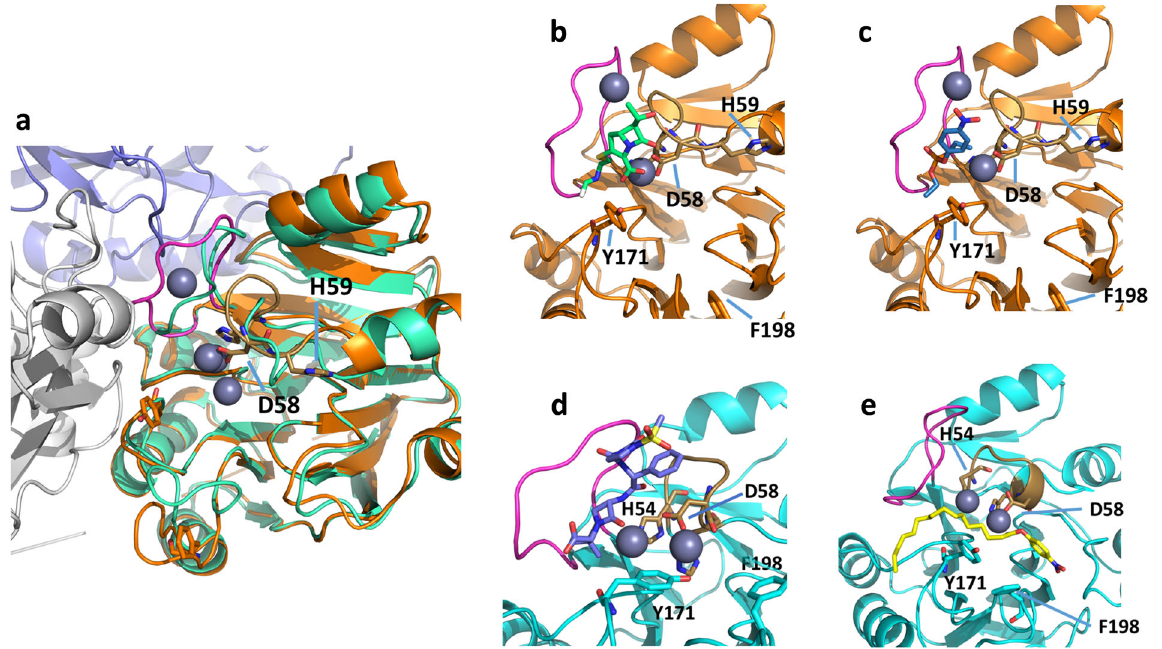
Fig. 4 Predicted binding modes of substrates in MD-generated structures of the Igni18 monomer and trimer. a Differences between the X-ray crystal structure (green) and an exemplary MD-generated structure (orange, navy, white) with the trimer interface loop (magenta) widening the pocket in the latter structure to allow substrate access. The active site loop binding the zinc ions is shown sand colored and in stick representation. Exemplary binding mode models of imipenem ( b ; lime), paraoxon-ethyl ( c ; blue), mezlocillin ( d ; navy), and p NP-palmitate ( e ; yellow) in the Igni18 trimer at 90 °C ( b , c ; orange) and the Igni18 monomer at 27 °C ( d , e ; light blue). The interface loop is colored magenta while the active site loop binding the zinc ions is shown sand colored and in stick representation. Y171 and F198, which interact with e.g. p NP-palmitate are shown in stick representation and